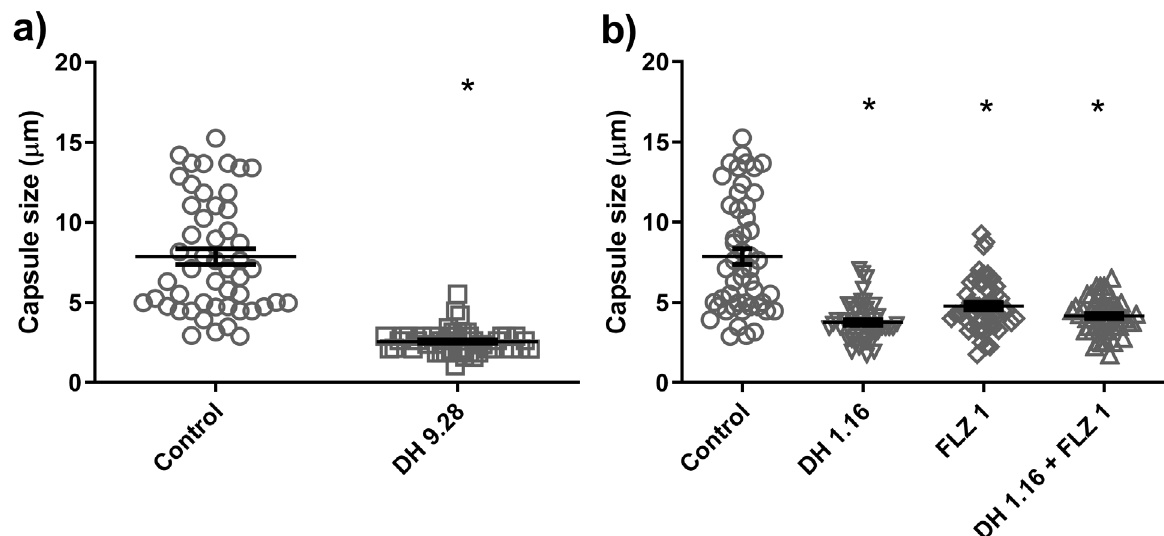
Figure 1. Effect of treatment on capsule size of C. neoformans . a) DH at the minimal subinhibitory concentration (Sub-MIC) of 9.28 μg/mL. b) DH in concentrations equivalent to the synergistic value (treatments alone and in combination). Fifty cells were measured for each group. DH: duloxetine hydrochloride; FLZ: fluconazole; Control: C. neoformans ATCC H99 5 × 10 6 cells /mL. (*): represents statistical difference in relation to the control (p < 0.05).